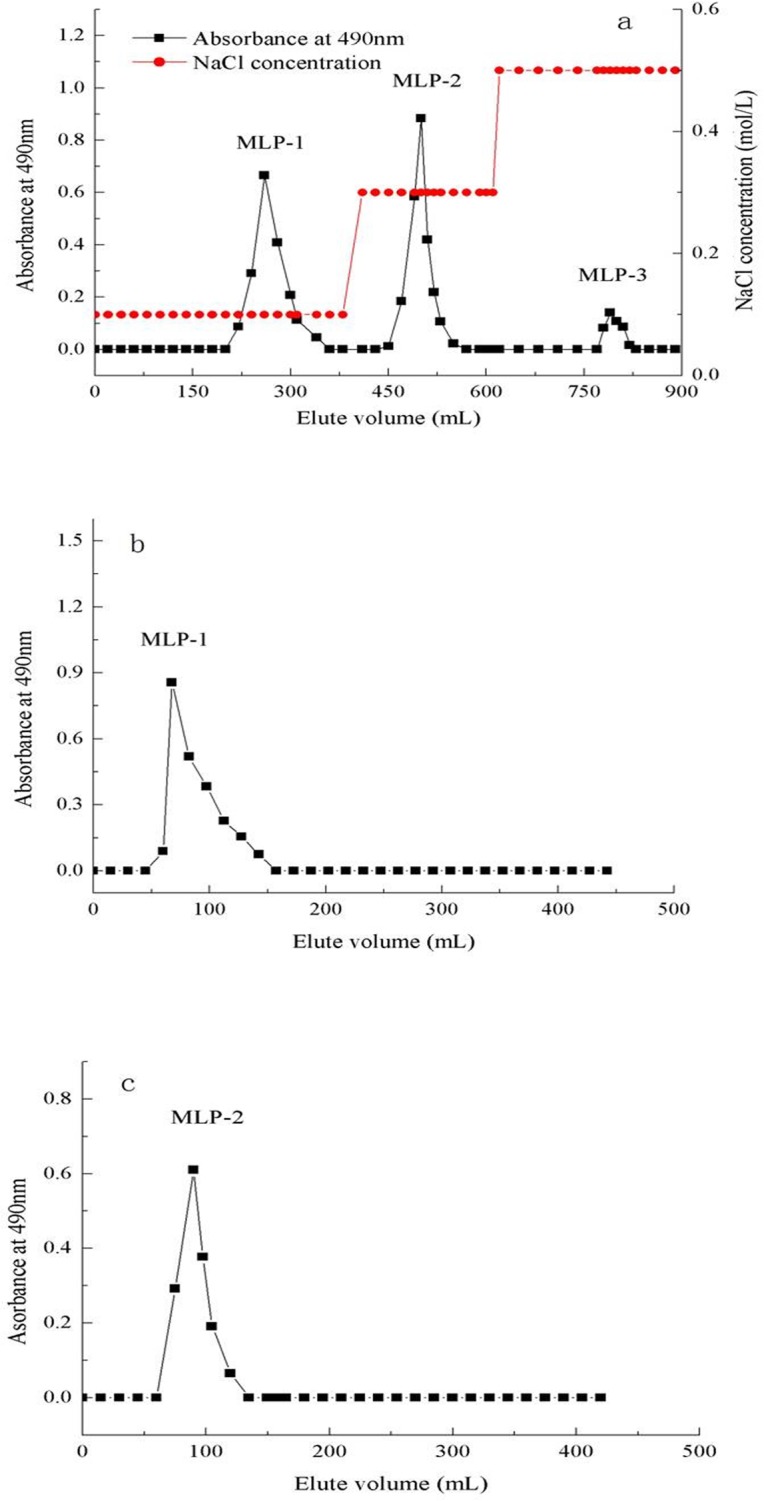
Elution chromatograms of the polysaccharides from mulberry leaves.(a) Elution curve of crude MLP from a DEAE-52 cellulose column; (b) elution curve of the MLP-1 fraction from a Sephadex G-100 column; and (c) elution curve of the MLP-2 fraction from a Sephadex G-100 column.